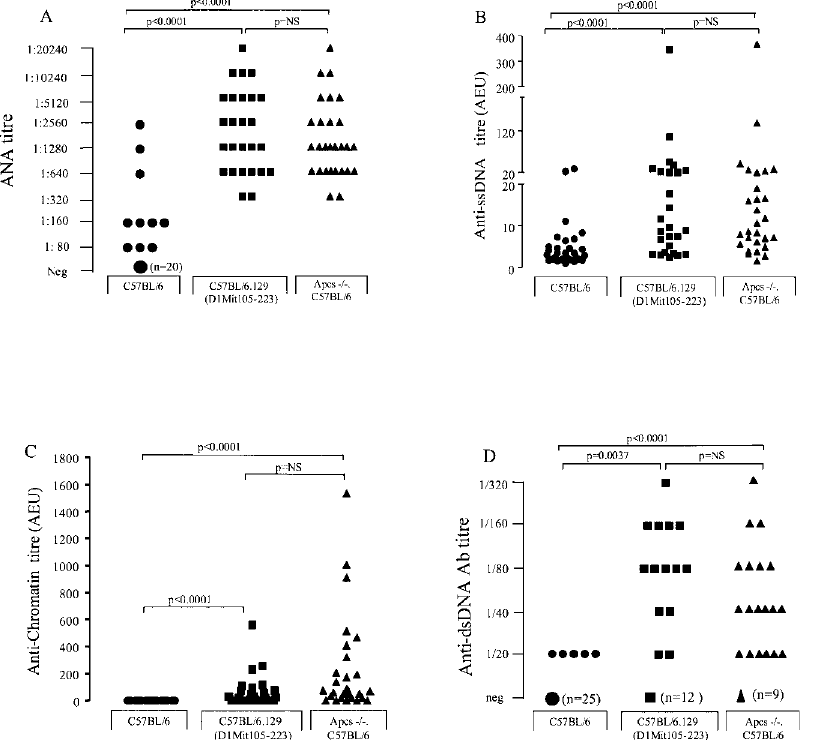
Figure 8. Auto-Ab Profiles (A) ANA titres in C57BL/6 mice, C57BL/ 6. Apcs (cid:1) / (cid:1) mice, and C57 BL/ 6.129(D1Mit105–223) congenic mice at 1 y of age. Small symbols represent one mouse; large symbols, a variable number of animals as indicated in parentheses. Serum sample were titrated to endpoint. (B and C) Anti-ssDNA (B) and anti- chromatin (C) Ab levels in the same cohorts of mice as in (A). The Ab levels are expressed in AEUs related to a standard positive sample, which was assigned a value of 100 AEU. (D) Anti-dsDNA Ab levels. Serum sam- ples were screened at 1:20. Samples that were positive were titrated to endpoint.